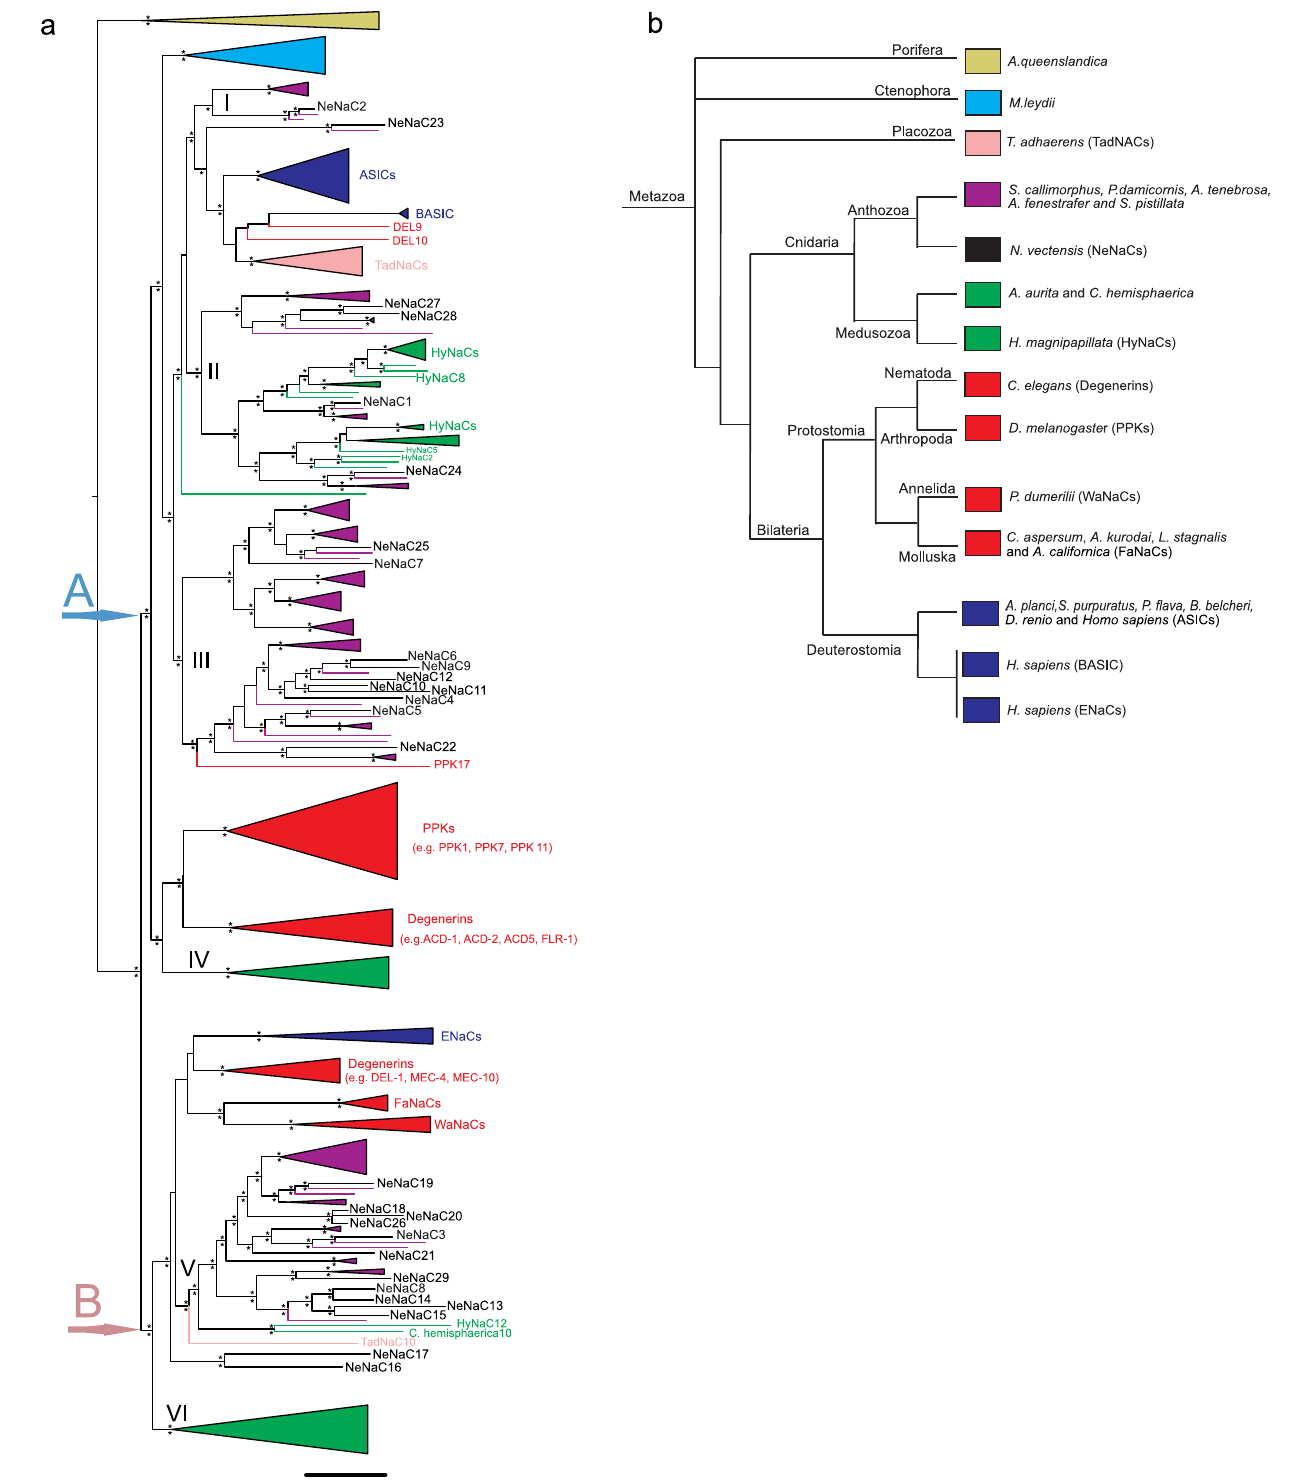
Fig. 1 Molecular phylogenetic tree of the DEG/ENaC channel superfamily with A. queenslandica as an outgroup. a The tree was constructed with the IQ- Tree software (see Materials and Methods). The branches of some clades are collapsed. Asterisks above and below branches denote a support value > 65% for the three different methods calculated in IQTREE and bayesian posterior probabilities >0.65 calculated in phylobayes, respectively. b Schematic representation of the phylogenetic relationship of the main groups of species selected for the sampling of their DEG/ENaCs.